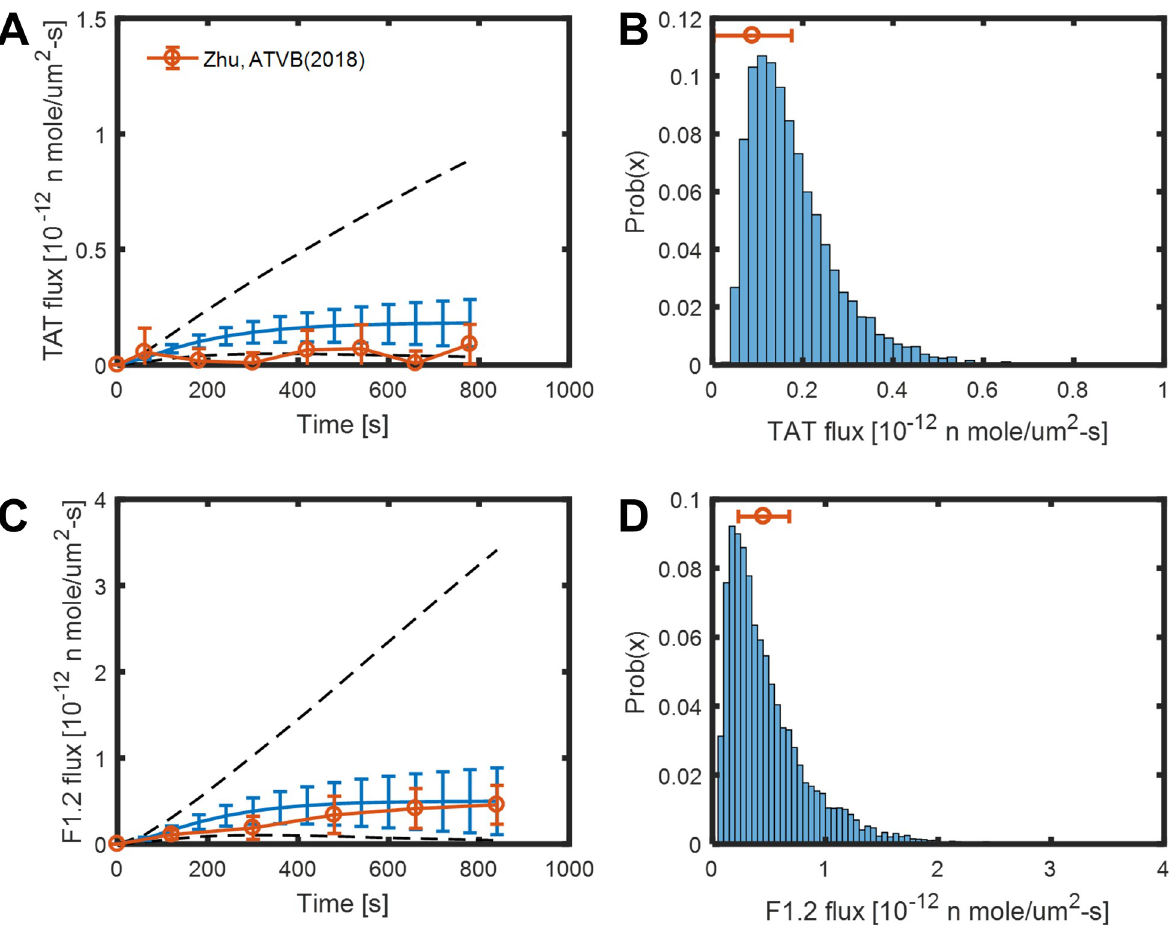
Fig 6. Transient convection-diffusion of thrombin into and out of a fibrin domain exposed to venous flow. The mean, standard deviation, range (A, C) and the distribution at 800 sec (B, D) of TAT and F1.2 flux of 10000 MC simulations varying plasma protein levels and thrombin binding sites ± 50% uniformly and independently. The experimental data of blood clotting over collagen/TF from [19] are shown in red.